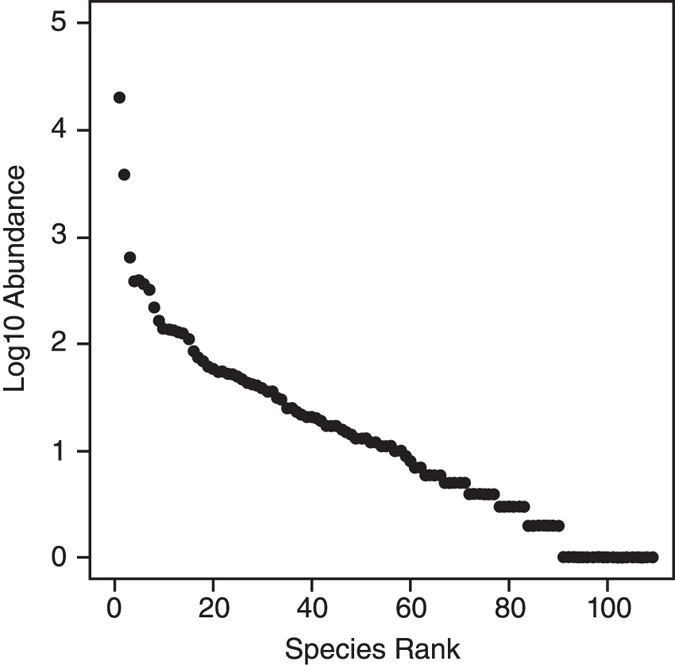
Rank abundance plot (Whittaker plot) for total foraminiferal assemblage (all four sampling intervals combined) from Heron reef-flat.The observed pattern is identical for each sampling interval when assessed individually.